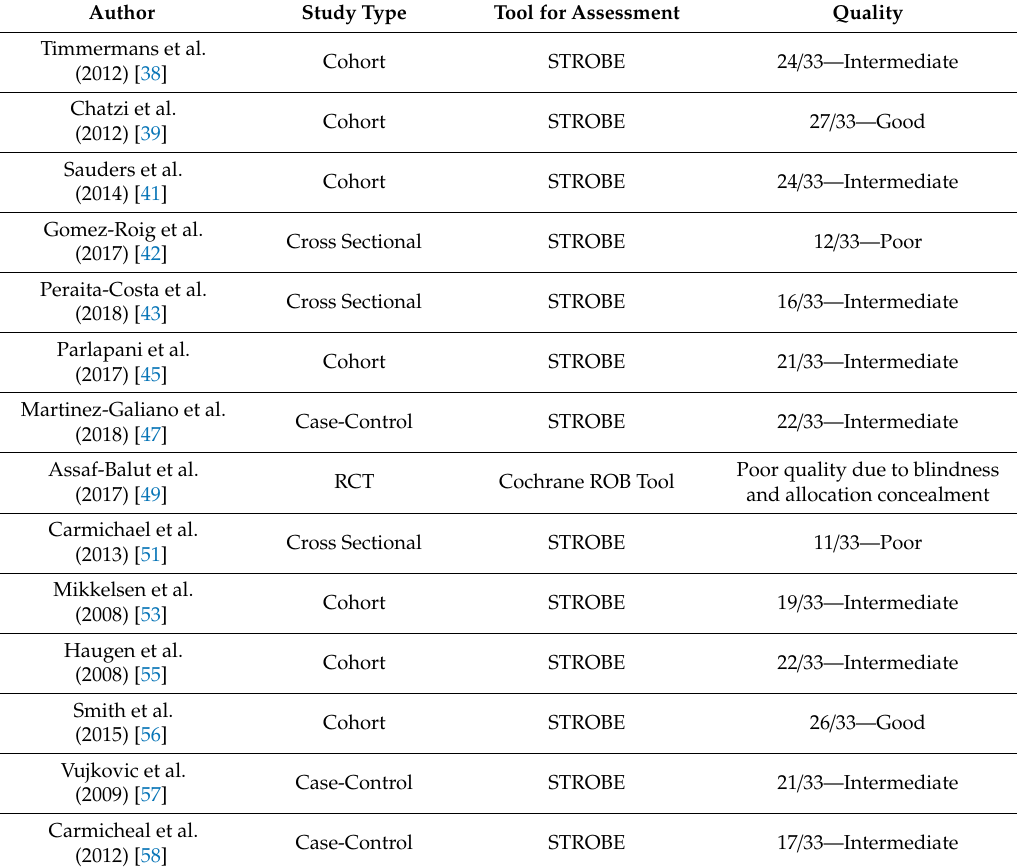
Table 2. Risk of bias of the included